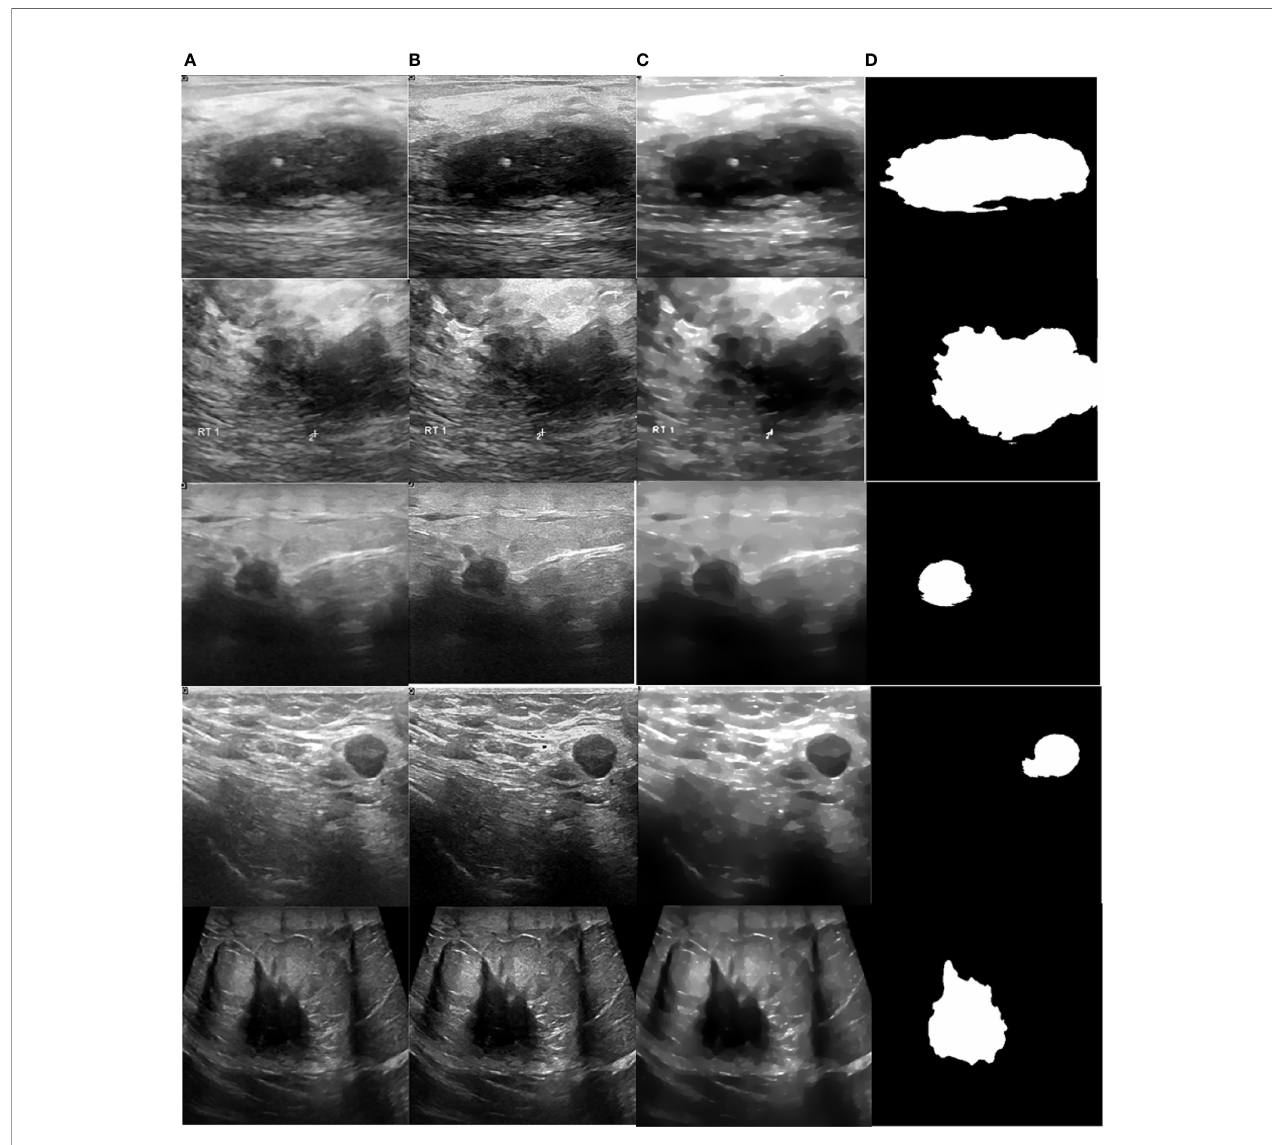
FIGURE 10 | Processed malignant images. (A) US image, (B) enhancement, (C) despeckling, and (D)